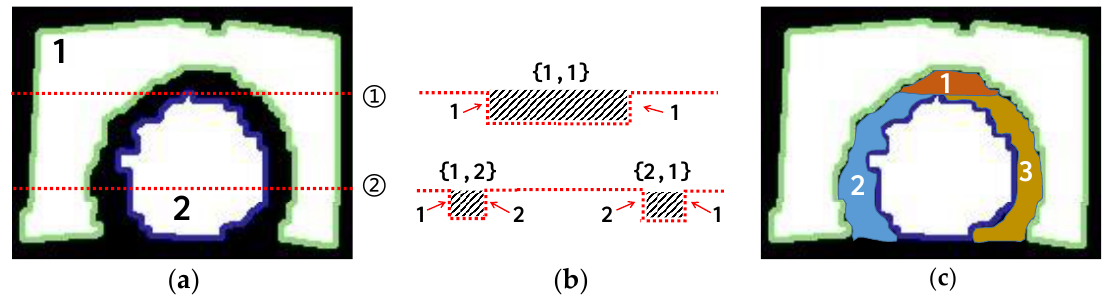
Figure 5. Region segmentation ( a ) Results of initial region segmentation and edge detection; ( b ) the scanline-based segmentation of discontinuous regions; ( c ) segmentation results of discontinuous regions. First, the canny operator was adopted to find corresponding contours of current regions, which were marked in green and blue lines as in Figure 5a. Then, the whole image was scanned, as in Figure 5a, from up to down. For each scanline, brightness variations will occur when meeting the detected contours, which is also the boundary between continuous and discontinuous regions. Here we denote the positions of brightness variation by the labels of the involved continuous region. Take the scanline 1 (cid:13) in Figure 5a,b as an example. Both the two positions where brightness variation occurs are labelled 1. Therefore, the definition of a discontinuous region can be set to be D { p , q } , with p and q denoting D (cid:48) s nearest left/right brightness variation positions respectively. Based on this definition, there are three discontinuous regions, D { 1, 1 } , D { 1, 2 } , D { 2, 1 } as displayed in Figure 5c. In this